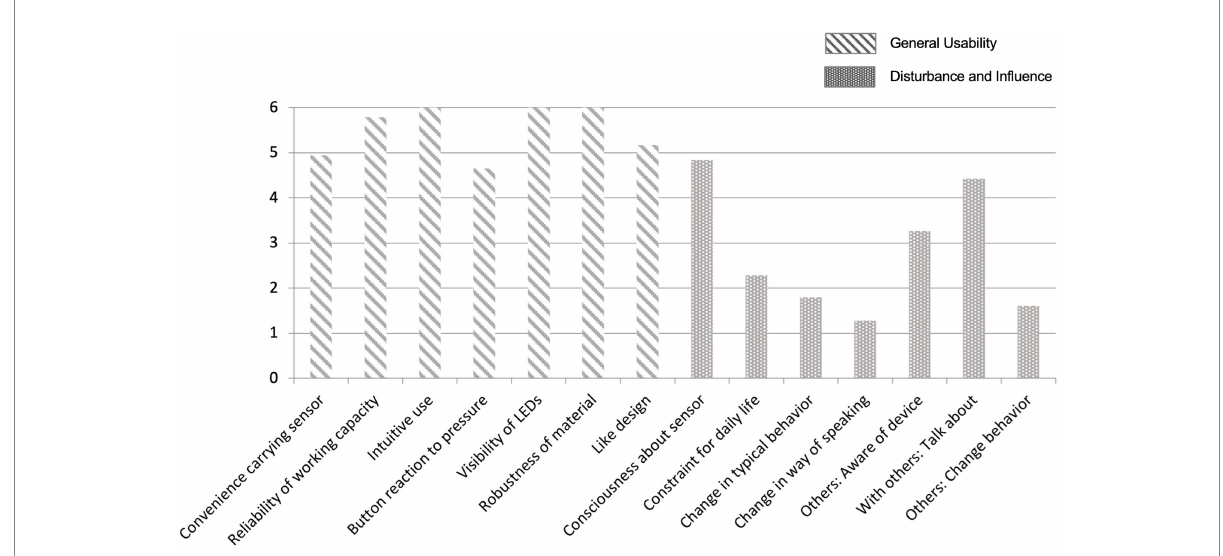
FIGURE 5 Evaluation of uTrail handling and experience by participants. Response scale ranged from 0 (does not apply at all) to 6 (applies very